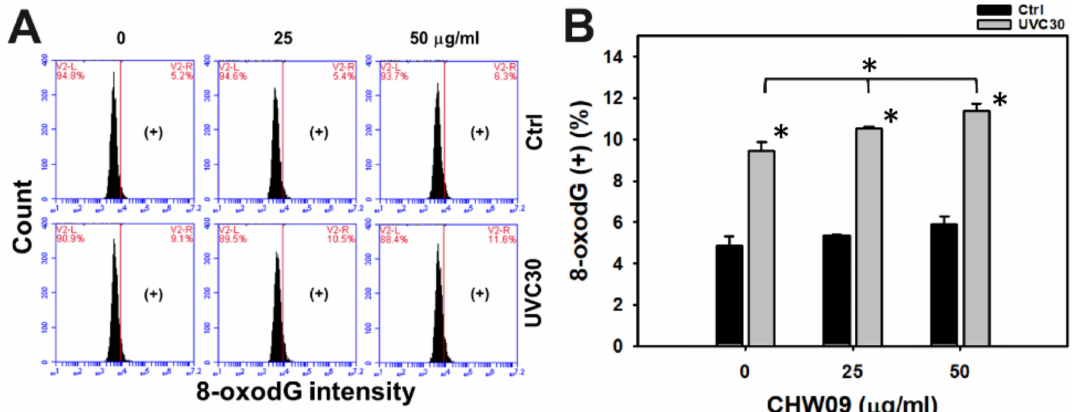
Figure 9. Changes of 8-oxodG of UVC and / or CHW09 treatments in oral cancer Ca9-22 cells. Cells were pretreated with UVC irradiation (0 and 30 J / m 2 ) and / or post-treated with CHW09 (control, 25, and 50 µ g / mL) for 24 h. ( A ) Representative pattern of 8-oxodG analysis for UVC and / or CHW09 treatment. ( + ) in the right side indicates the 8-oxodG ( + ) (%). ( B ) Statistics in Figure 9A. Data, mean ± SD ( n = 3 independent experiments). For multiple comparison, significance of the di ff erence was examined by one-way ANOVA and the Tukey HSD Post Hoc Test. *, p < 0.0001. * without line indicates the significance between control and UVC30. * with line indicates the significance between UVC30 / CHW09 and